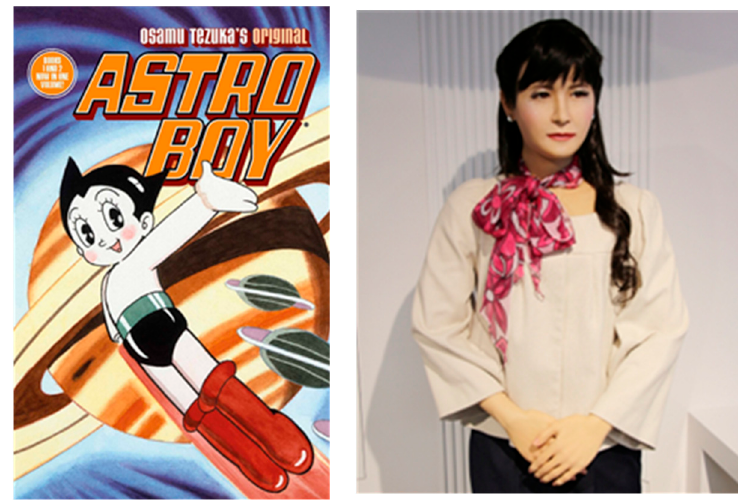
Figure 8. The robot Astro Boy ( left ) and the humanoid Madoka Mirai ( right ).